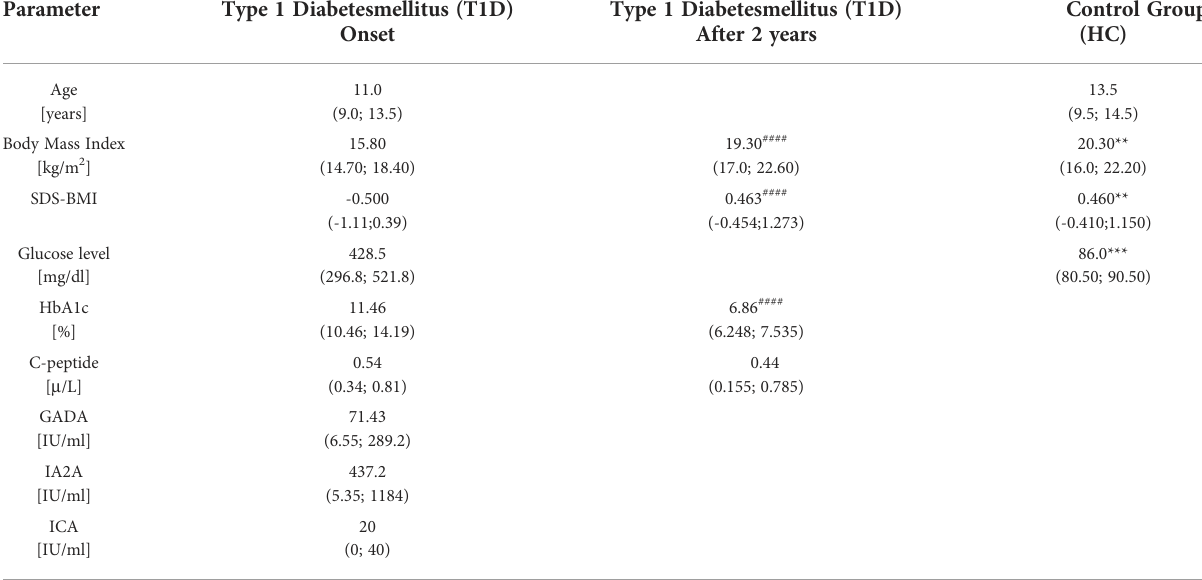
TABLE 1 The clinical characteristic of the studied groups in context of laboratory parameters - type 1 diabetic pediatric patients (T1D) and healthy control (HC).